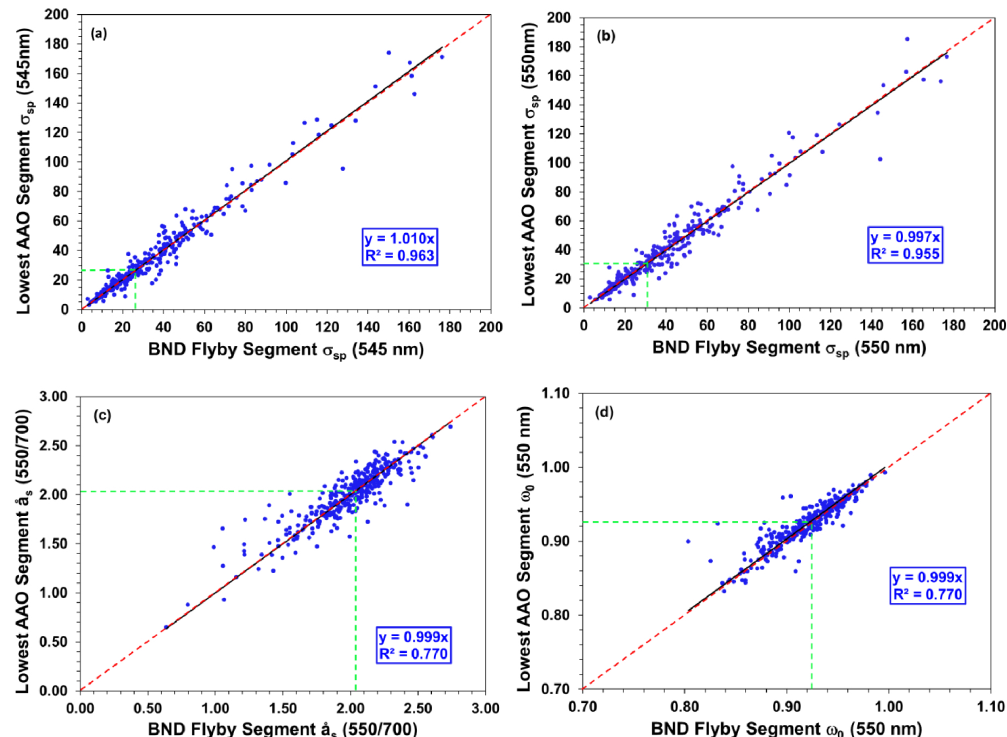
Fig. 7. Comparisons of AAO lowest-segment profile data with BND tower flyby data. Data points represent 5-min flight segment averages of aerosols at the same altitude and displaced by ∼ 15km. (a) σ sp for D p < 1µm particles. (b) σ sp for “total” size cut particles. (c) ˚a s for “total” size cut particles. (d) ω 0 for “total” size cut particles. Red dashed line = 1:1, green dashed lines show the median values for each population, and black solid line shows the linear regression fit line (forced through the